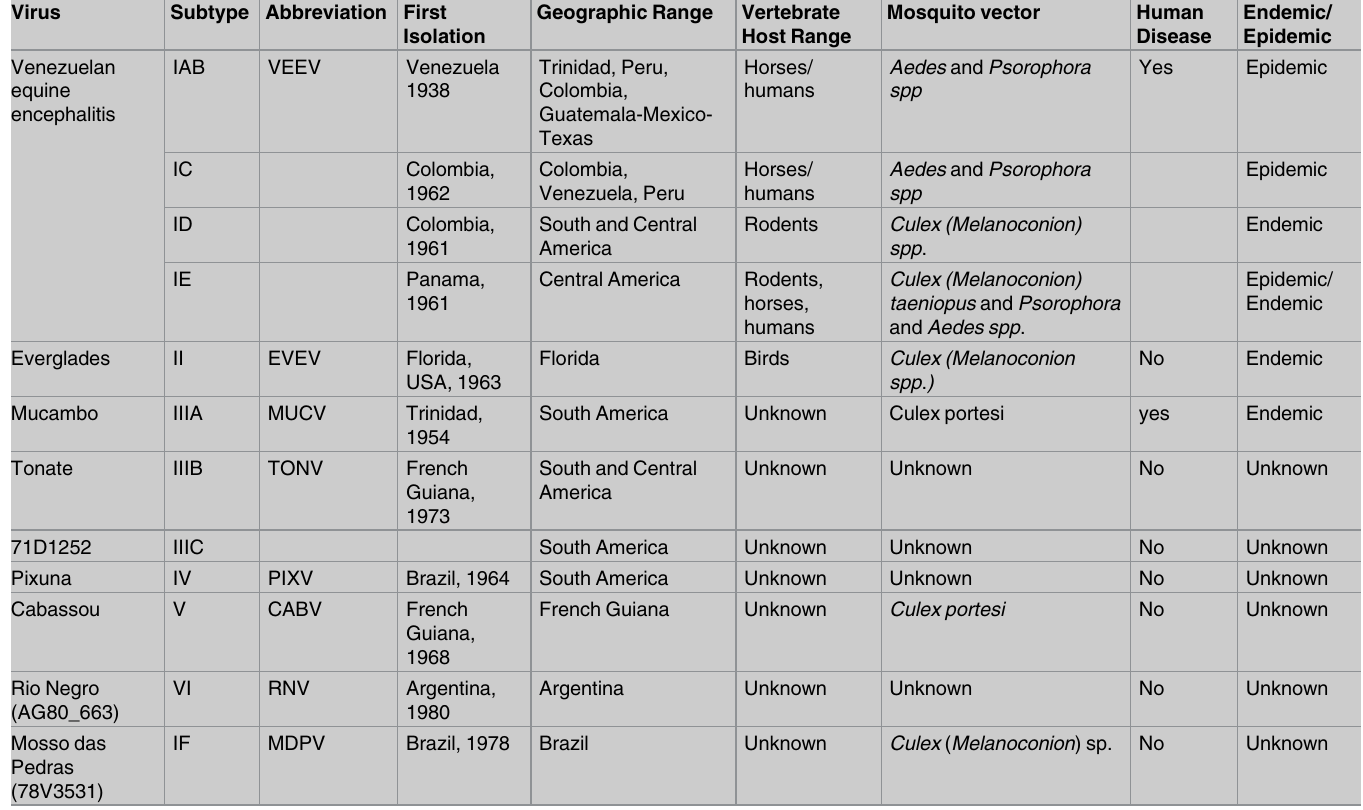
Table 1. The subtypes of VEE complex alphaviruses and their transmission cycles.